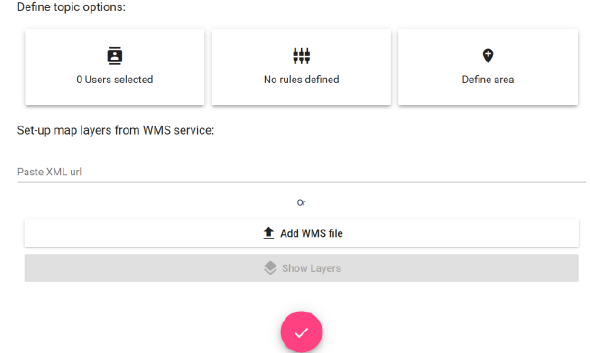
Figure 7. smarticipate Back-End – User Invitation and Rules Configuration Interface © AIT 2018